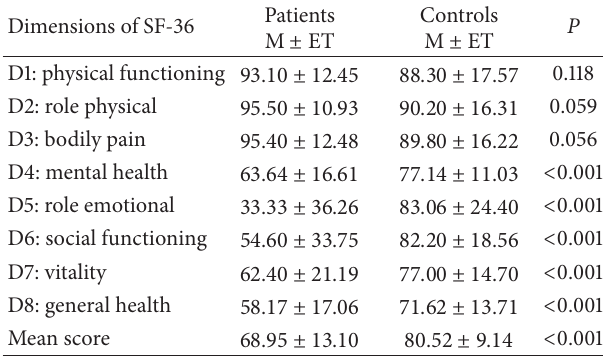
Table 1: Quality of life comparisons between AA patients and